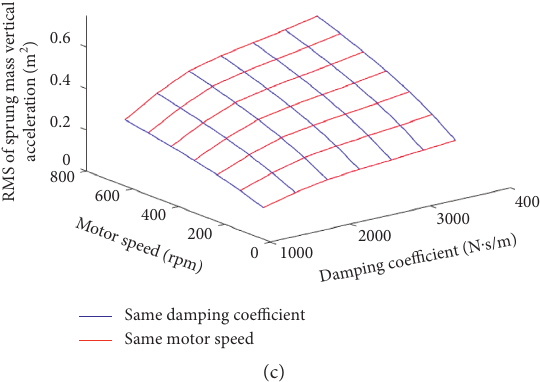
Figure 11: RMS of vertical evaluation indices under different damping coefficients and motor speeds. (a) Suspension deflection. (b) Tire dynamic load. (c) Sprung mass vertical